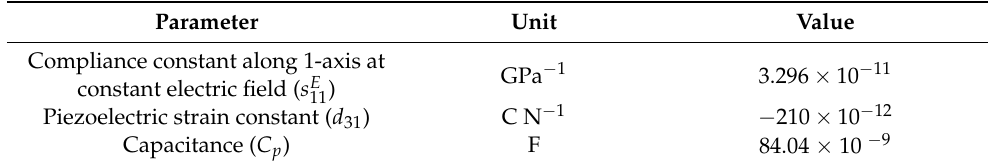
Table 3. Electromechanical properties of the PE patch.